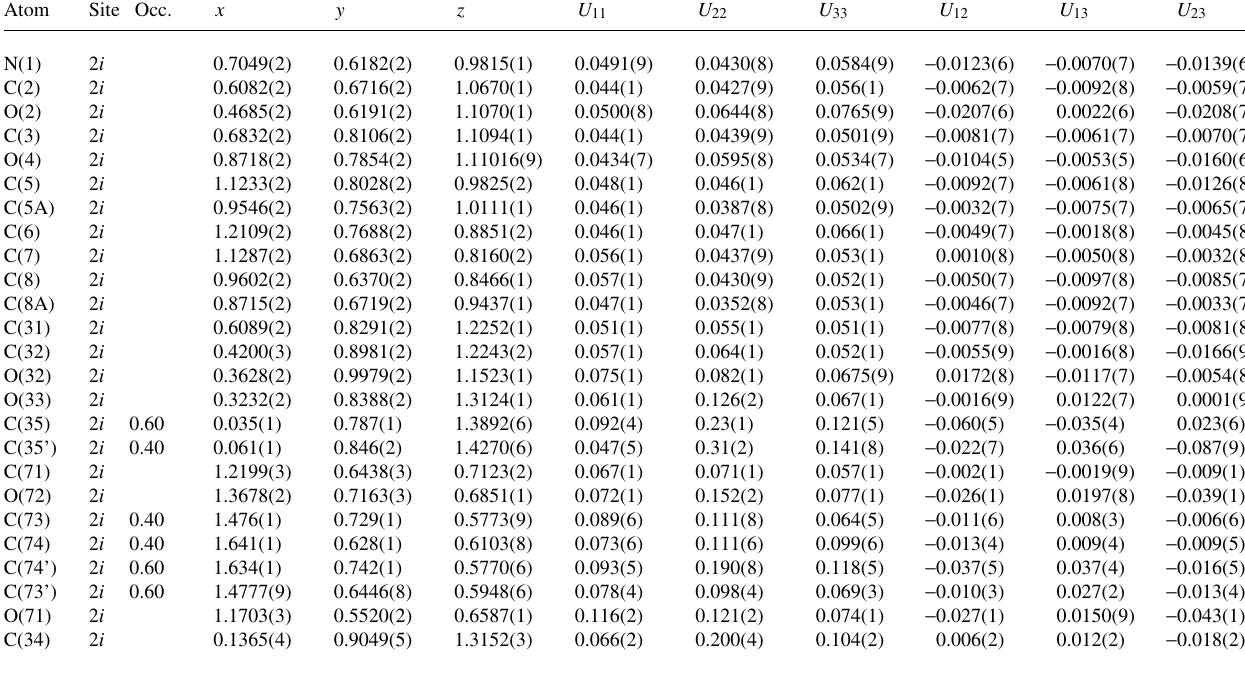
Table 3. Atomic coordinates and displacement parameters (in Å 2 )